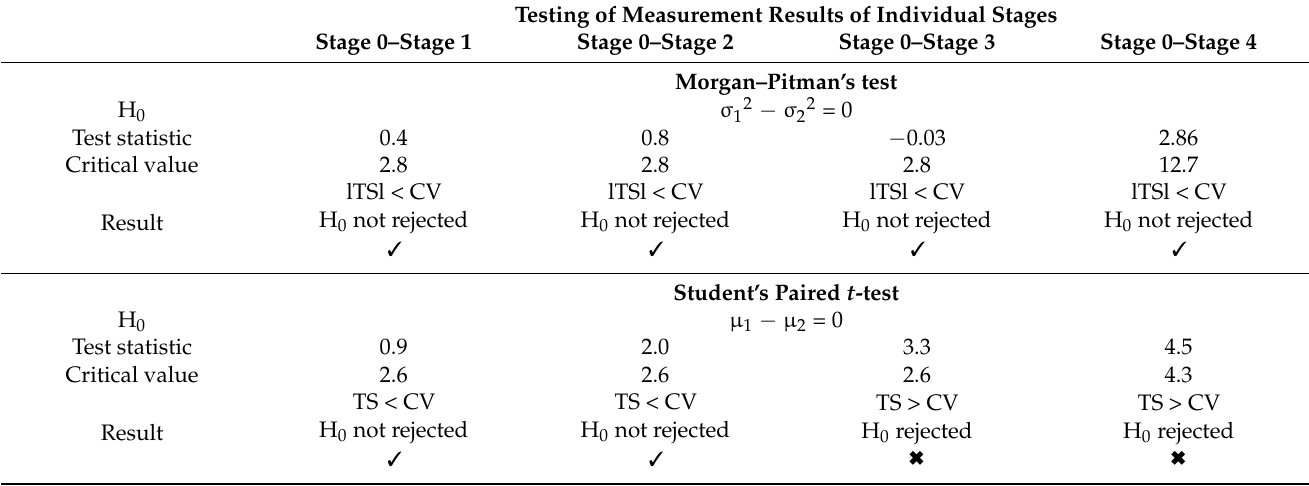
Table 5. Statistical testing of measurement results.